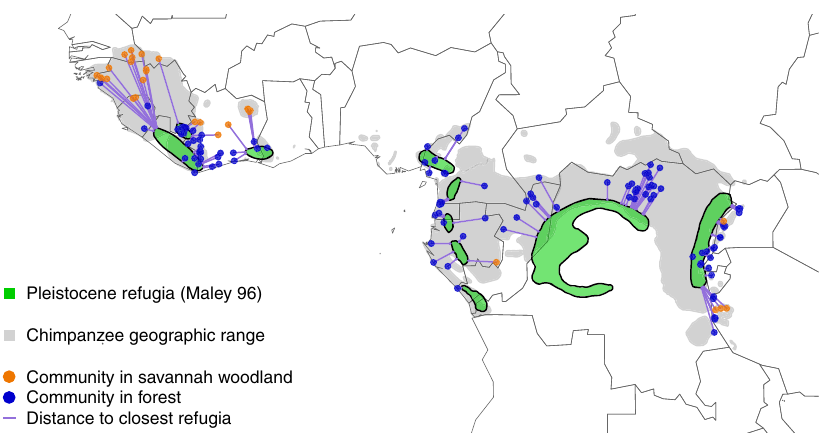
Fig. 1 Distance of chimpanzee communities to Pleistocene forest refugia. The green areas depict the Pleistocene forest refugia as described by Maley 39 , purple lines show straight-line distances calculated between the center point of a chimpanzee community to the limit of the nearest forest refuge, and dots represent a unique chimpanzee community in a predominantly forest (blue) or savannah woodland (orange) habitat. Chimpanzee geographic range